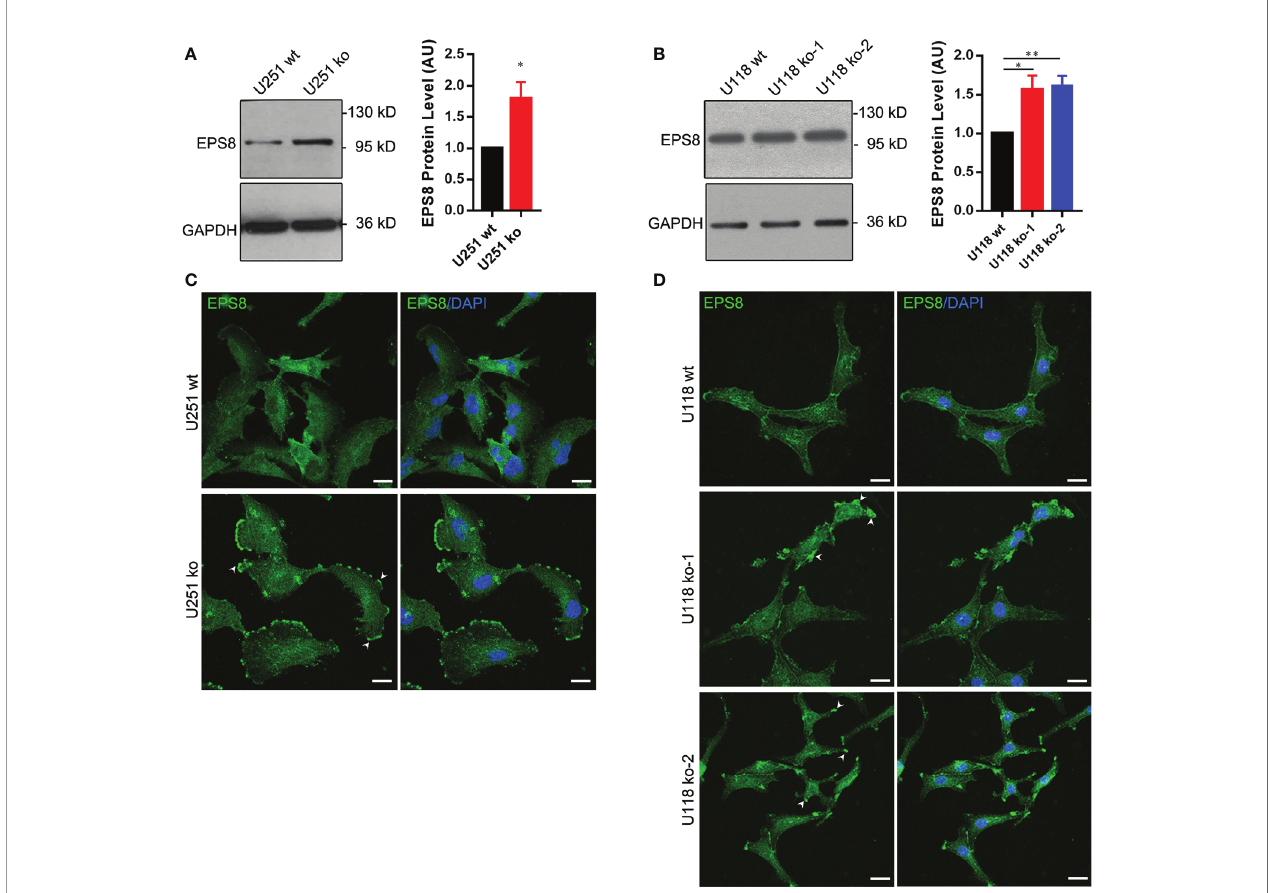
FIGURE 5 | MLK3 regulates the localization of EPS8 in U251 and U118 cells. (A, B) The MAP3K11 gene knockout increases the expression of EPS8 in U251 (A) and U118 (B) cells. Relative levels of MLK3 were normalized to U251 wt or U118 wt groups. GAPDH was used as a loading control. Two-tailed Student ’ s t -test. n = 3, * P < 0.05, ** P < 0.01. AU, arbitrary unit. (C, D) The MAP3K11 gene knockout alters the location of EPS8 in U251 (C) and U118 (D) cells. The results shown are representative of at least three independent cultures. EPS8 (green); DAPI-stained nuclei (blue). Scale bars, 20 m